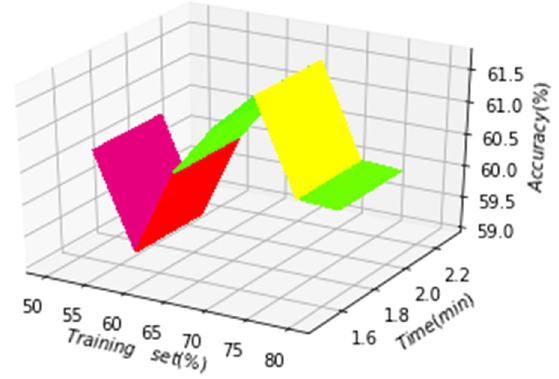
Fig. 8: Training Set Vs Time And Accuracy